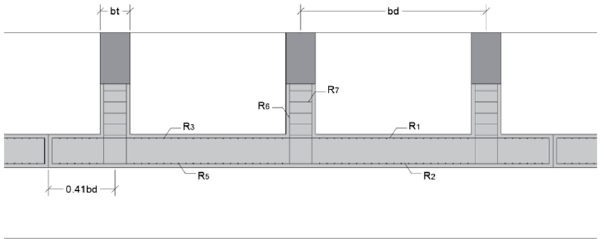
Figure 2. Geometrical variables and reinforcements of the buttressed wall, cross-section.